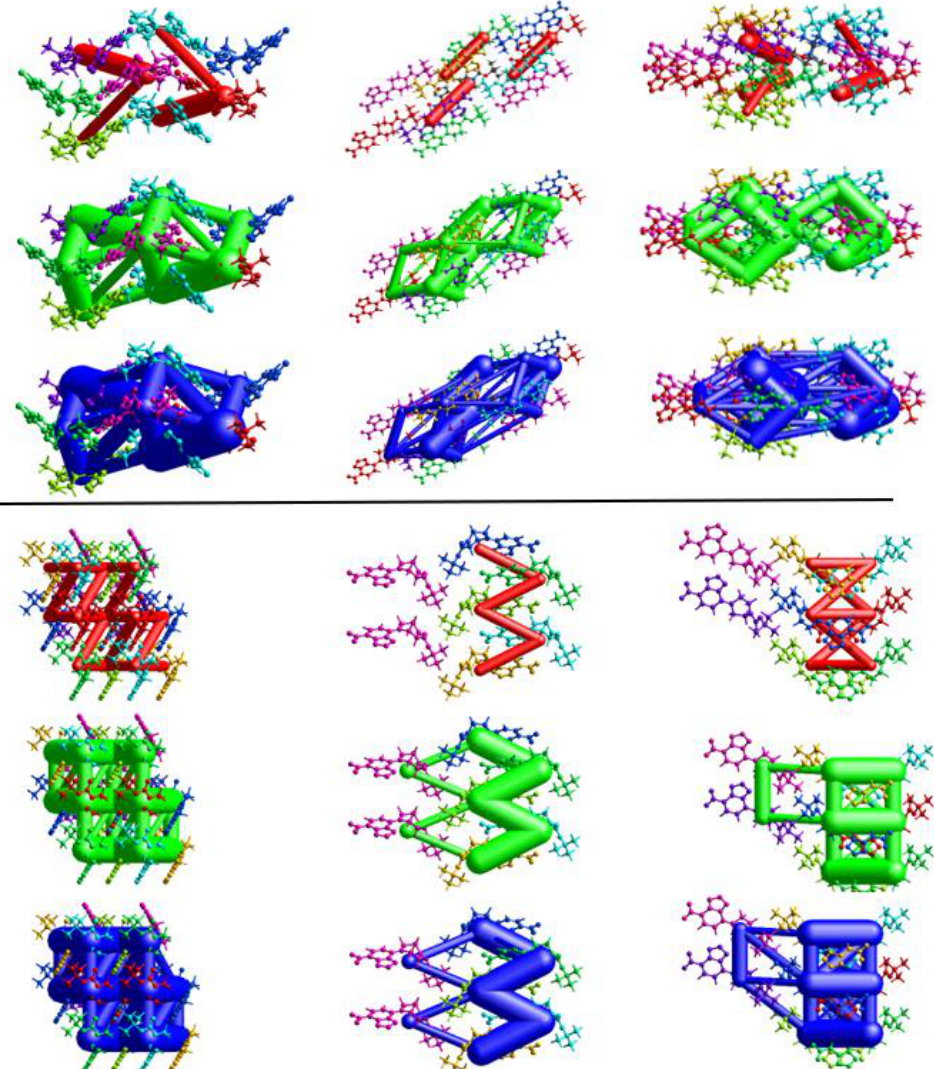
Figure 16. Energy frameworks for 1-M ( top ) and 1-O ( bottom ) viewed from the a, b, c axis ( left to right ). Tube coloring indicates coulombic (red), dispersion (green), and total (blue) energies. A cutoff of 15 kJ/mol was used.